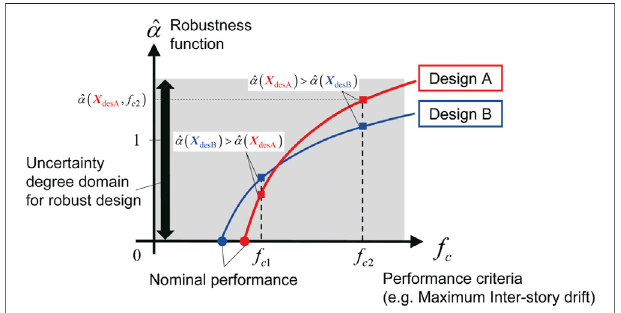
FIGURE 1 | Comparison of robustness functions for different designs.